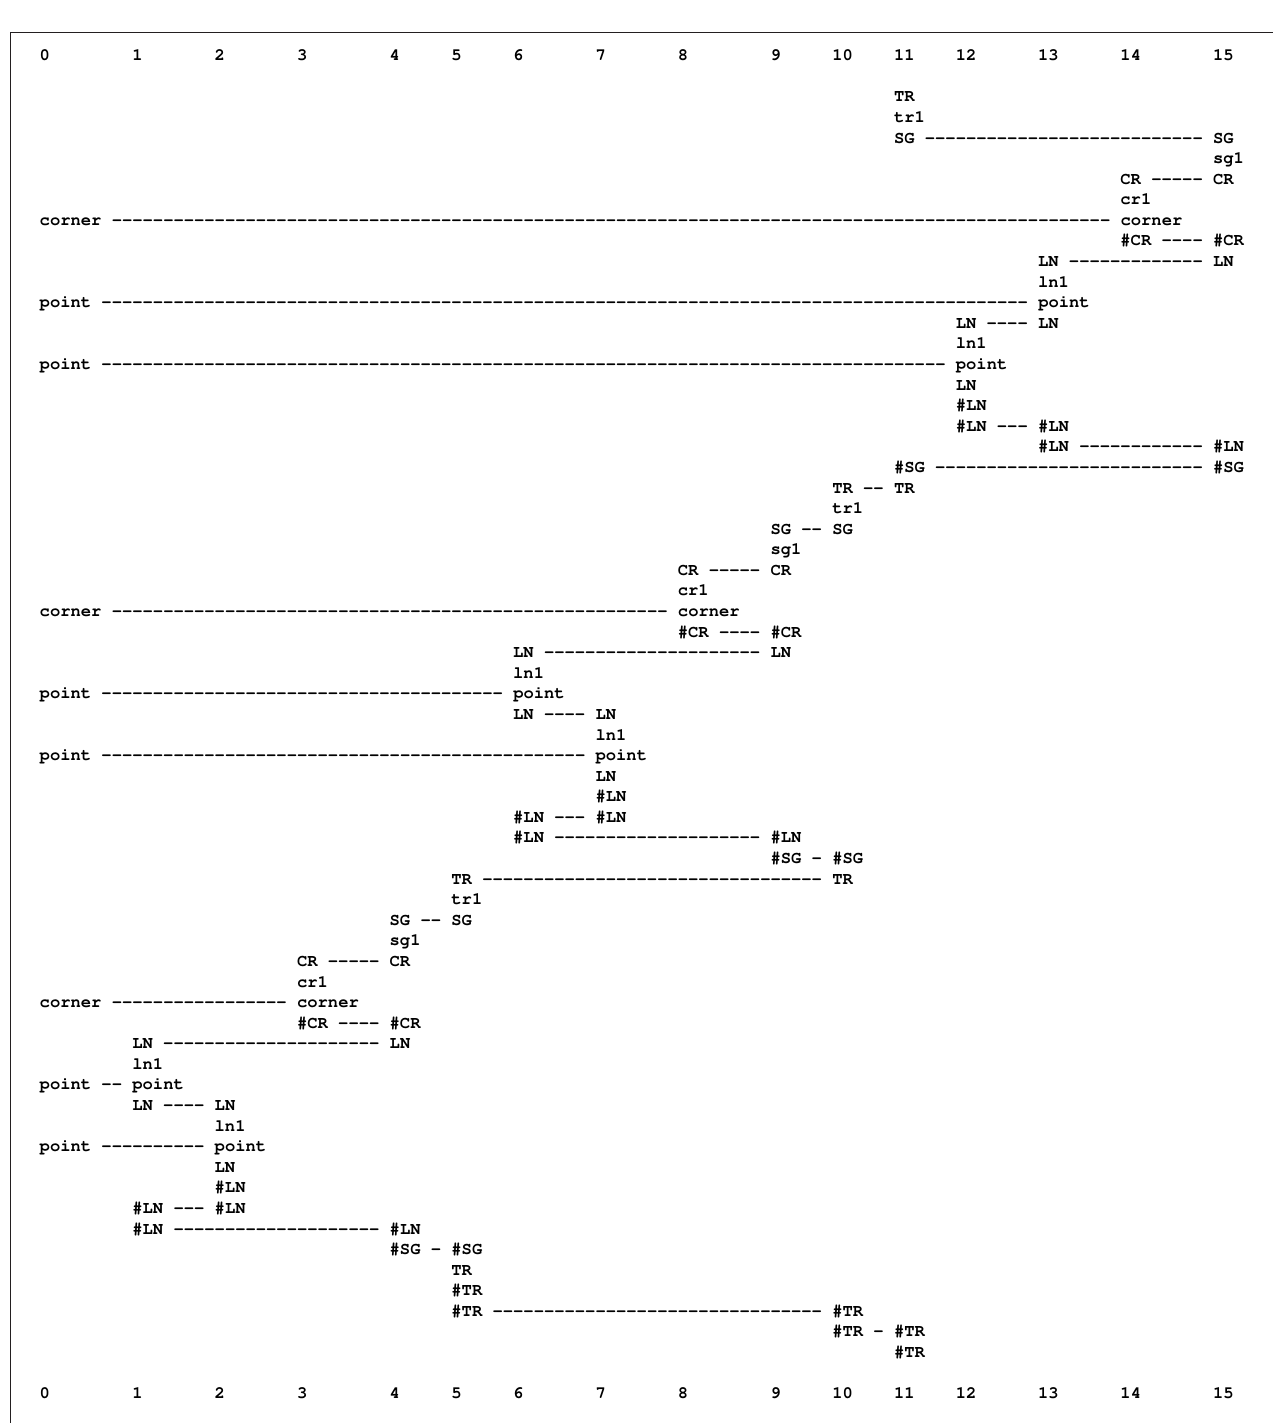
FIGURE 5 | A multiple alignment produced by the SP computer model showing how a one-dimensional analog of how an equilateral triangle may be perceived, as described in the text. Adapted from Wolff (2016, Figure 8), with